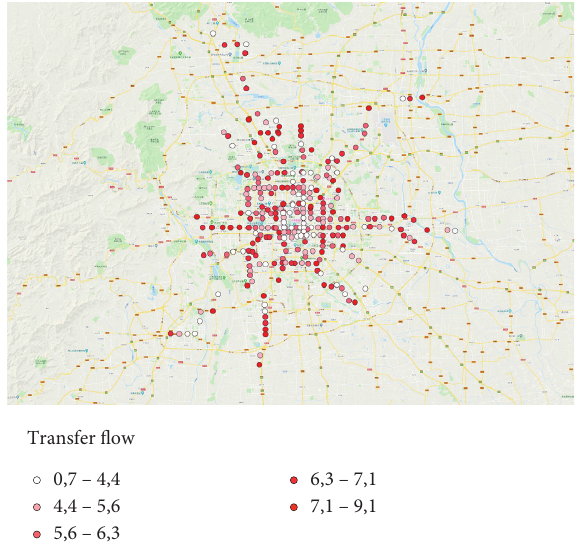
Figure 8: Transfer flow from bus to metro on one